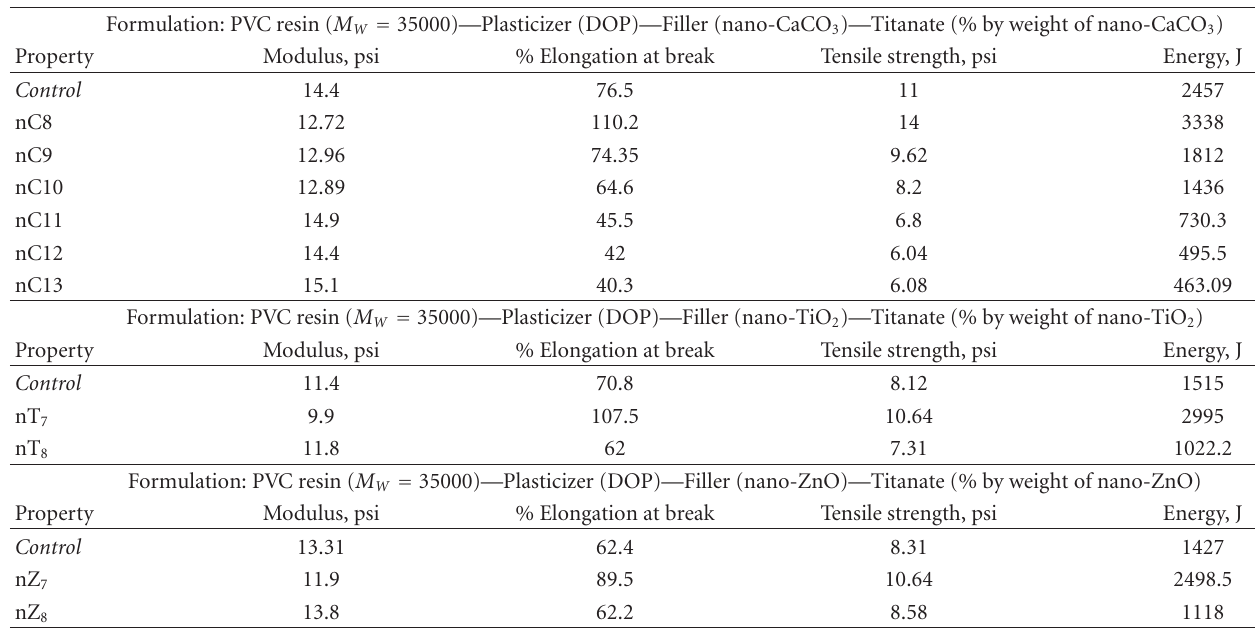
Table 4: Mechanical properties of prepared nanocomposites in the presence of titanate coupling